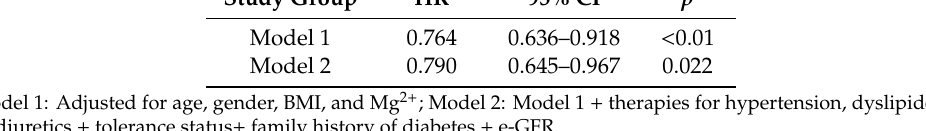
Table 5. Hazard ratio (HR) (95% CI) by multiple logistic regression analysis for the risk to develop T2DM. Study Group HR 95% CI p Model 1 0.764 0.636–0.918 < 0.01 Model 2 0.790